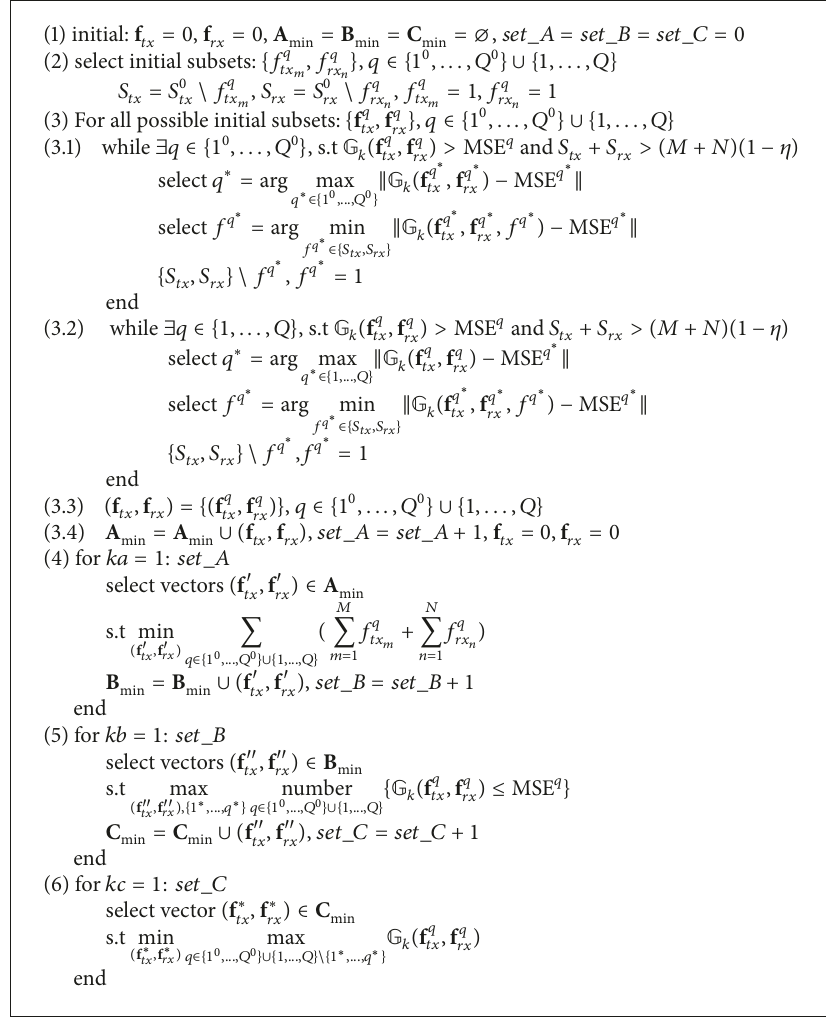
Algorithm 1: MFMLS subset selection